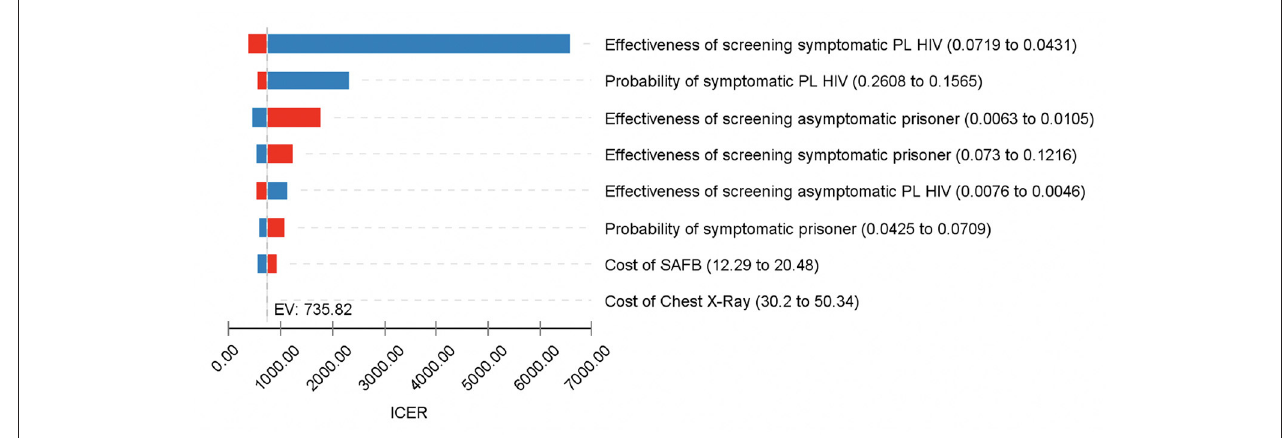
FIGURE 3 | One-Way Sensitivity Analysis for TB screening among PL HIV vs. prisoners; Tornado diagram of the significant parameters. Blue color represents decrease in parameters value, while red represents increase in parameters value. This diagram shows the sensitivity of the ICER values upon changes in the model parameters. Value for each parameter is substituted one by one, starting with the lowest plausible value to the highest plausible value. Parameters that have the highest impact on the model are shown at the top, while the least impact is displayed at the